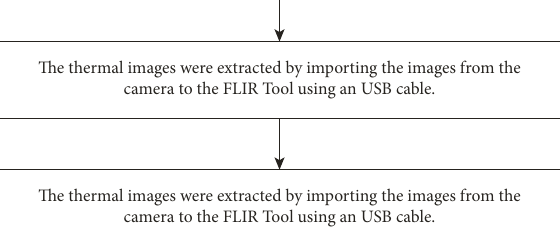
Figure 6: Methodology for data collection and clustering.